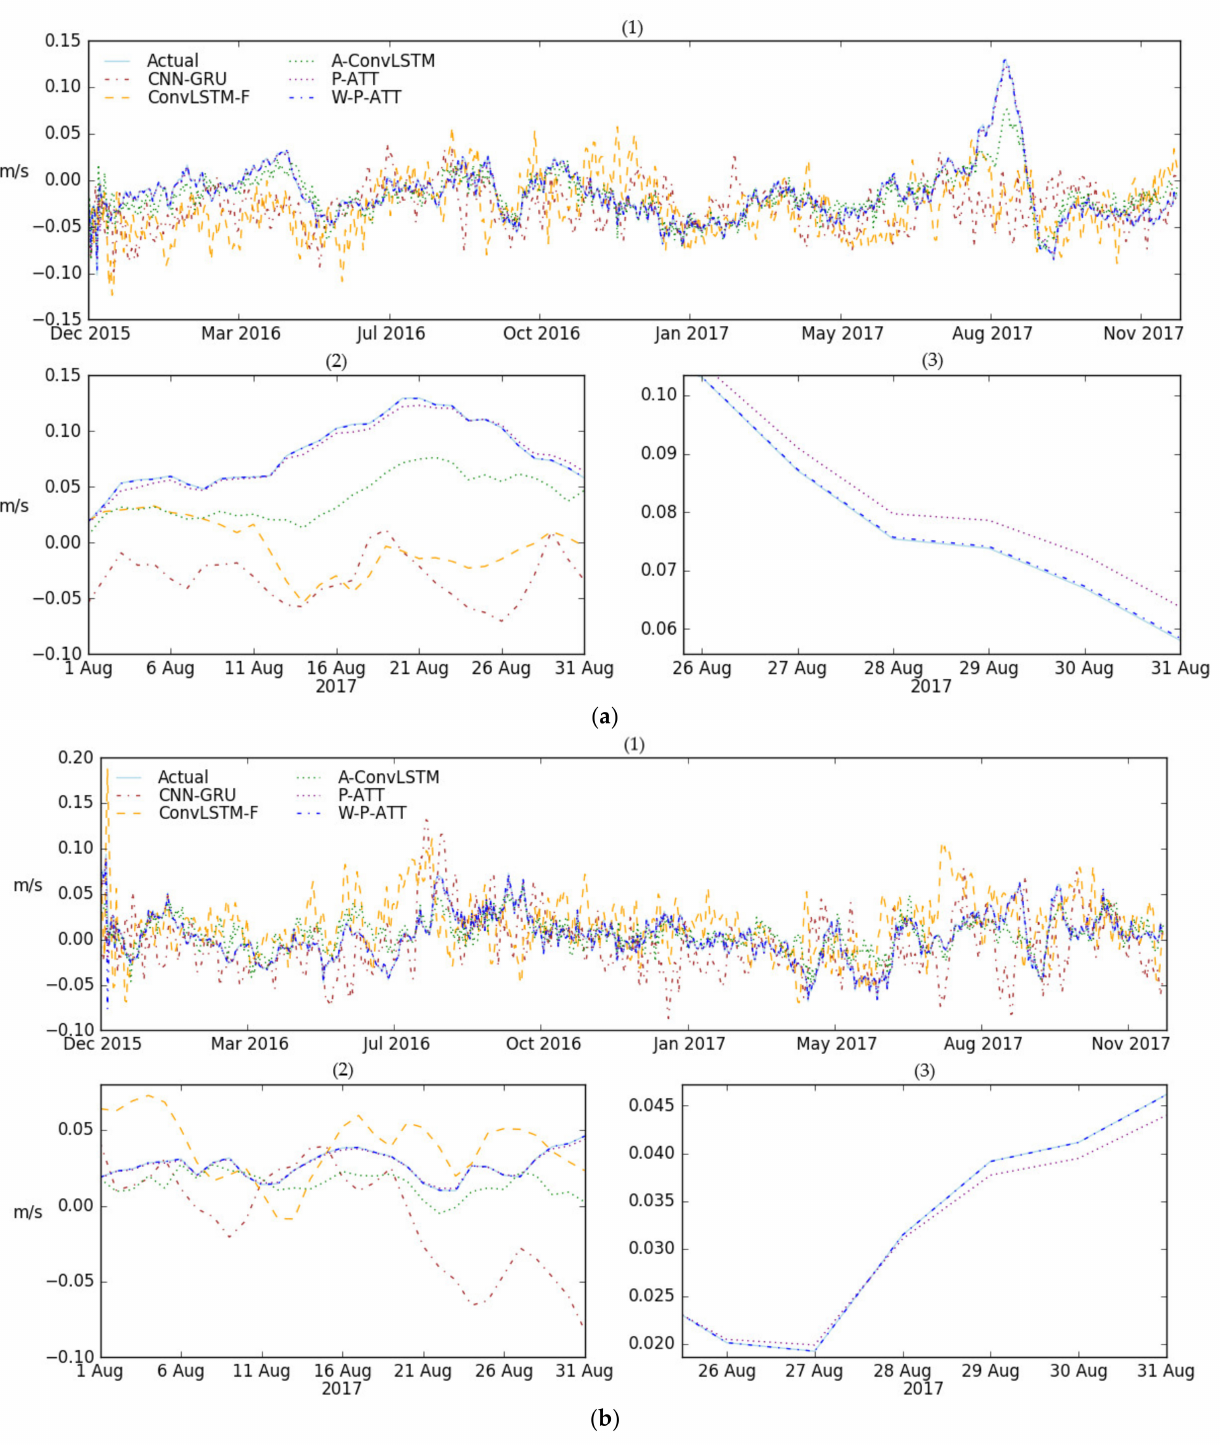
Figure 7. The comparison between the predicted OCs and observed OCs for spatial point (122.5 ◦ E, 30.25 ◦ N)—( a ) u_current, ( b ) v